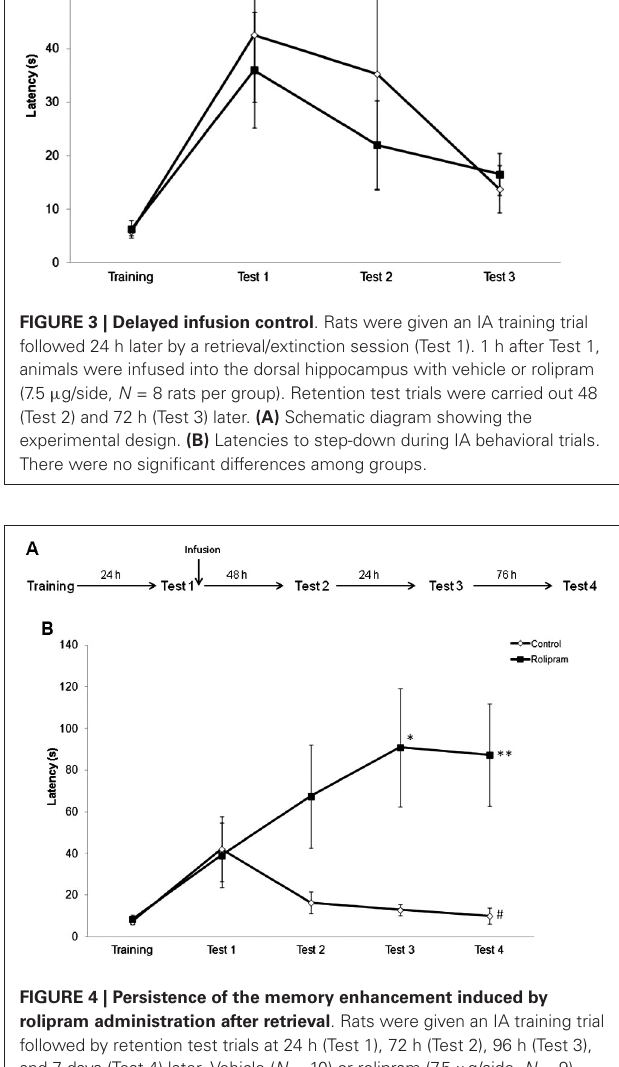
latencies across test trials (Friedman test, comparison across tests trials, H = 8.4, df = 3, P < 0.05) ( Figure 4B ). The results indicate that the enhancing effect of intrahippocampal rolipram given immediately after retrieval can last for at least 1